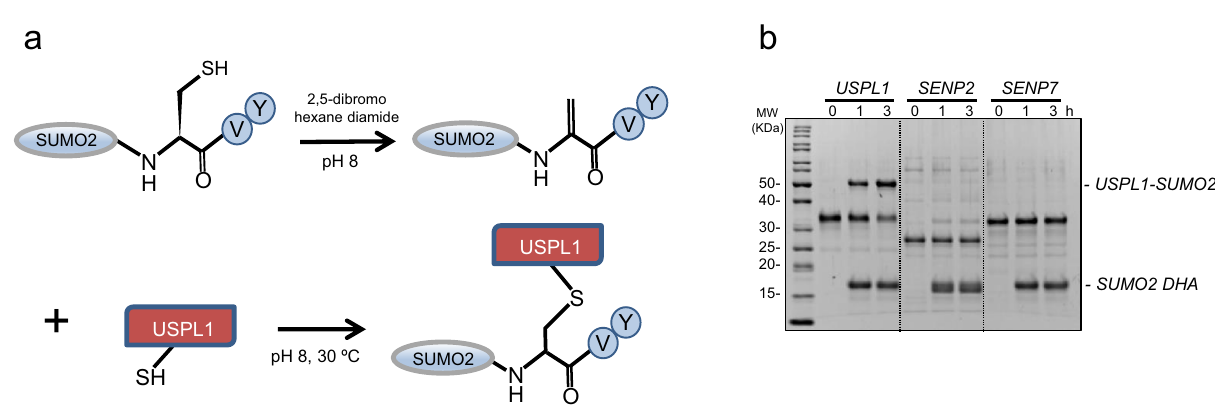
Fig. 1 Covalent thioether bond formation of SUMO2-DHA with USPL1 catalytic domain. a Schematic representation of the reaction to form the covalent thioether between the SUMO2-C48S/G93C precursor and USPL1 catalytic domain. b Active site probe assay for USPL1, SENP2, and SENP7 with SUMO2- DHA. Time course assay of USPL1, SENP2, and SENP7 at 2 μ M using the SUMO2-DHA substrate at 6 μ M at 30 °C for 3 h. n = 3 technical replicates. Source data are provided as a Source Data